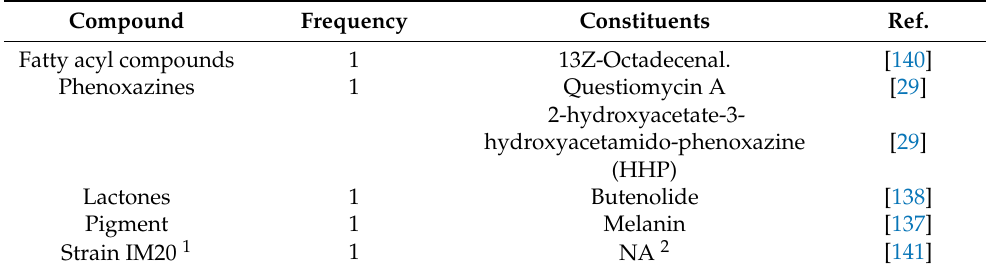
Table 7. Family compounds with QQ activity.